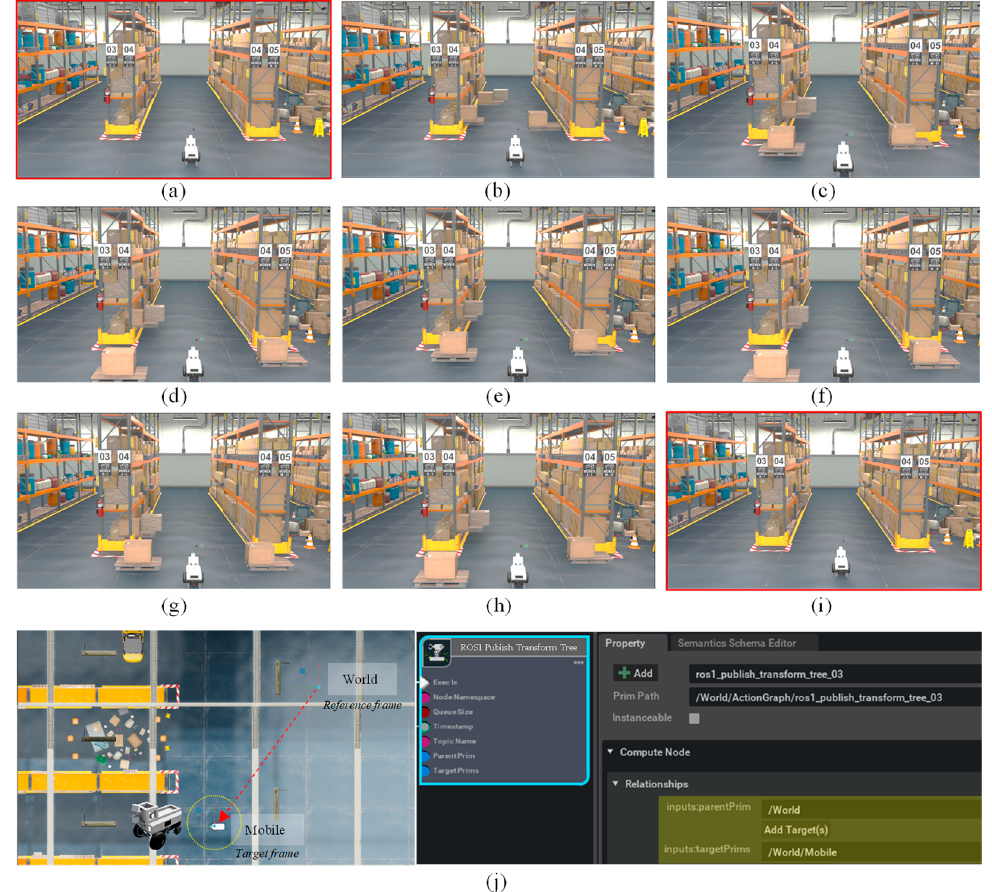
Figure 5. Multi-layered 3D NDT scan-matching scenario running in the Isaac Sim: ( a ) start w/o object teleport (same with original map); ( b ) start w/object teleport; ( c – h ) teleport events occurring every 10 s; ( i ) final scene identical with the original map; and ( j ) ground truth published from the Isaac Sim.